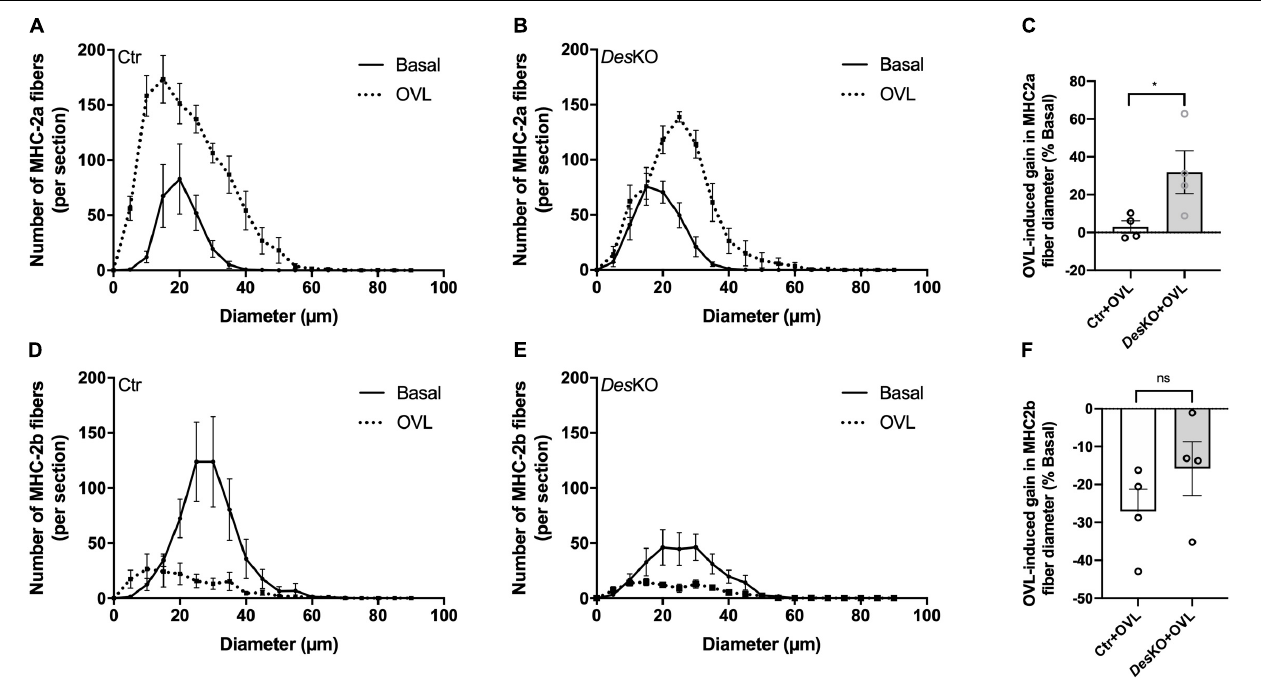
FIGURE 4 | Size distribution of plantaris muscle fibers is modified in DesKO mice after OVL. Size distribution of plantaris muscle fibers expressing only MHC-2a (A,B) or MHC-2b (D,E) for both genotypes (Ctr and Des KO) in basal condition (black line) or after 1 month of OVL (black dotted line). The gain or loss in these parameters was calculated compared to the corresponding basal condition for the Ctr + OVL and Des KO + OVL groups (C,F) . Data are given as means ± SEM. For the size distribution, n = 4 for all conditions ( n = 3 for Ctr + Basal group). Des KO, Desmin knock-out mice; Ctr, Control mice; OVL, mechanical overloading; MHC, myosin heavy chain. ns , non-significant, * p <